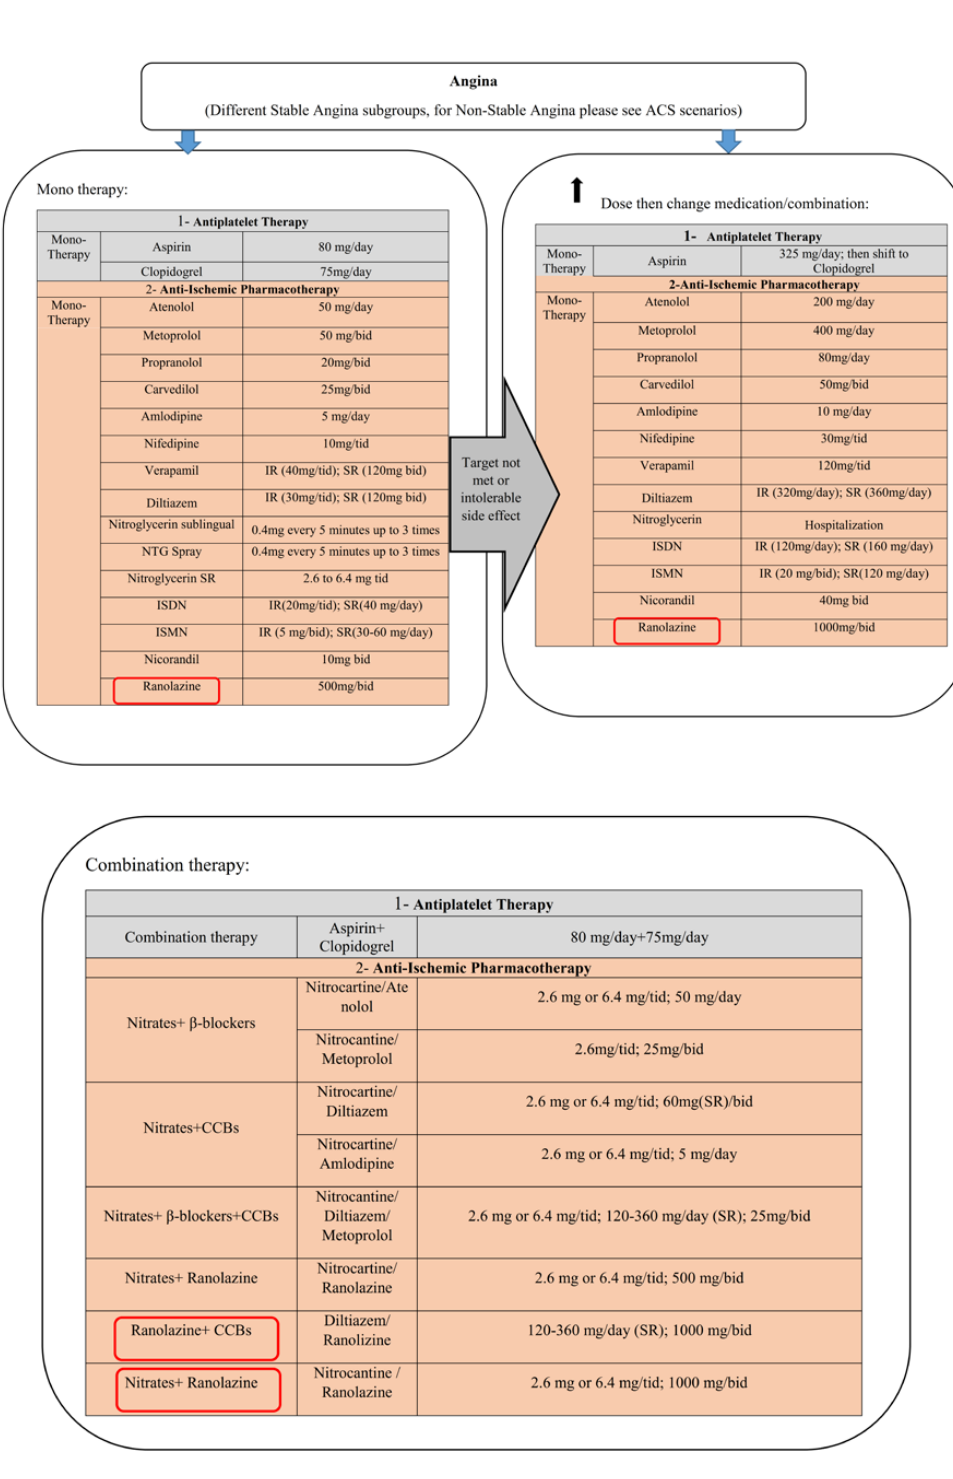
ff erent medication therapy scenarios in Figure 2B. The different medication therapy scenarios in angina. Figure A2. The di